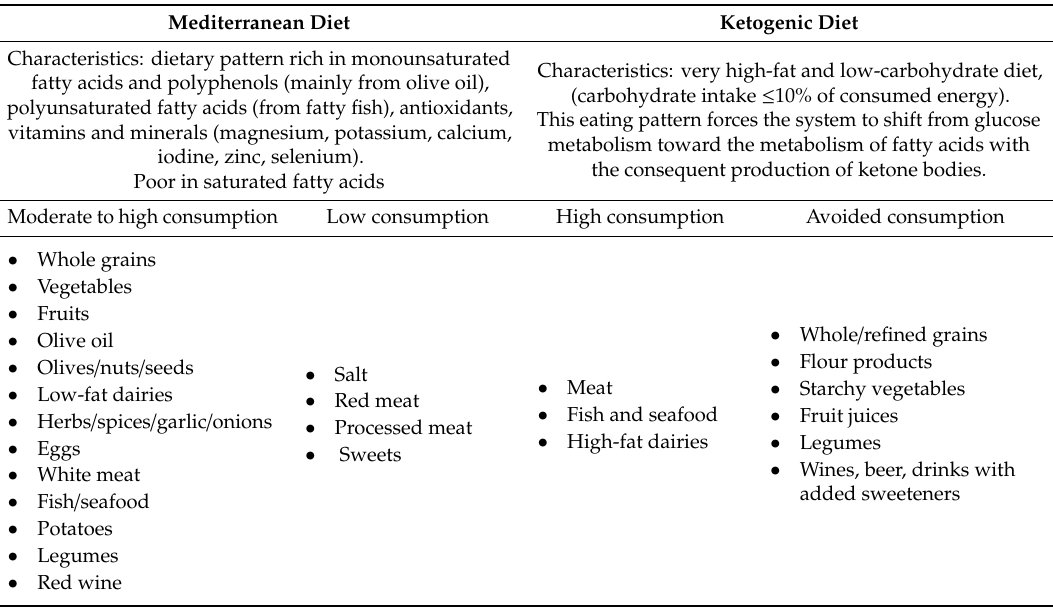
Table 1. Main characteristics of the Mediterranean and ketogenic diet eating patterns.